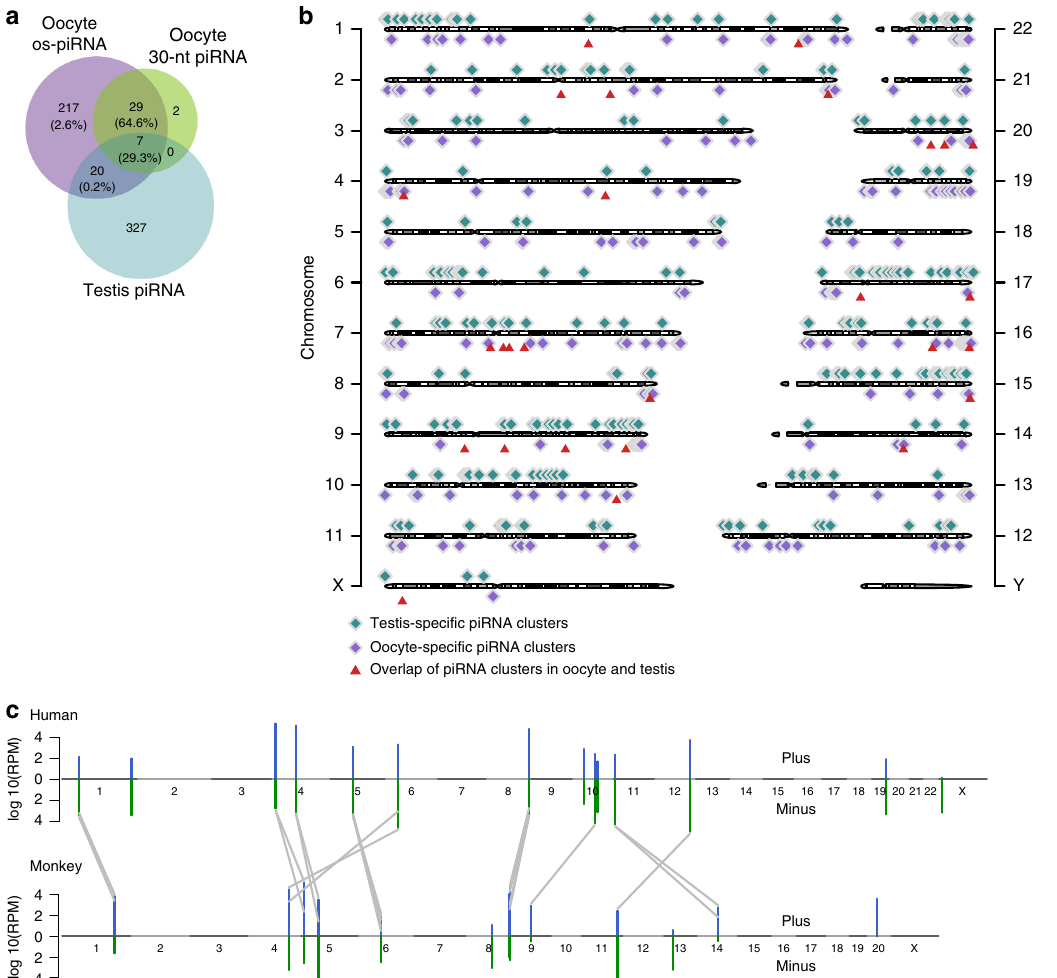
Fig. 5 Conservation of oocyte short-PIWI-interacting RNAs (os-piRNAs) in human and monkey. a The amount of overlap among the os-piRNA clusters in human oocytes, the 30-nt piRNA clusters in human oocytes, and the piRNA clusters in human testes. The numbers in the brackets represent the ratios of the os-piRNAs expressed in these overlapped clusters in human oocytes. b Locations of oocyte- and testis-piRNA clusters on human chromosomes. The os-piRNA and the 30-nt piRNA clusters in human oocytes were combined as piRNA clusters in human oocytes. c The orthologous relationship between human and monkey os-piRNA clusters. The chromosomes of each species are represented vertically from chromosome 1 to the sex chromosomes. Gray lines indicate orthologous cluster pairs. Clusters with an average reads assigned per million genome-mapped read (RPM) ≥ 1000 in humans or monkeys are depicted. Source data of b – c are provided in the Source Data fi